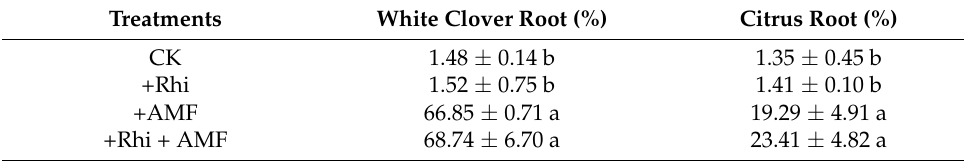
Table 2. Mycorrhizal colonization of white clover and citrus grown in pots.